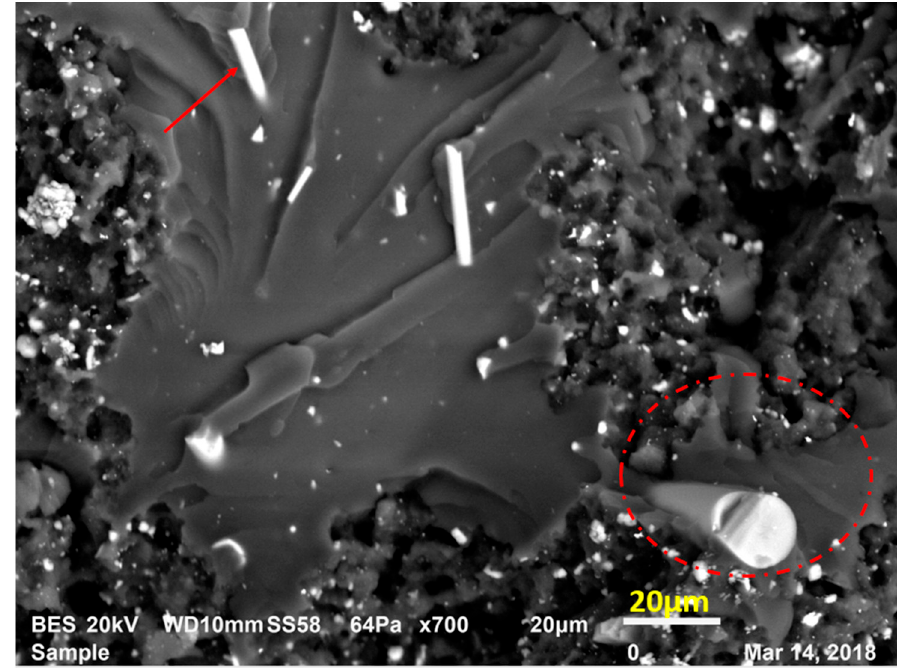
Figure 9. Fiber bridging mechanism in LRAL group composites.